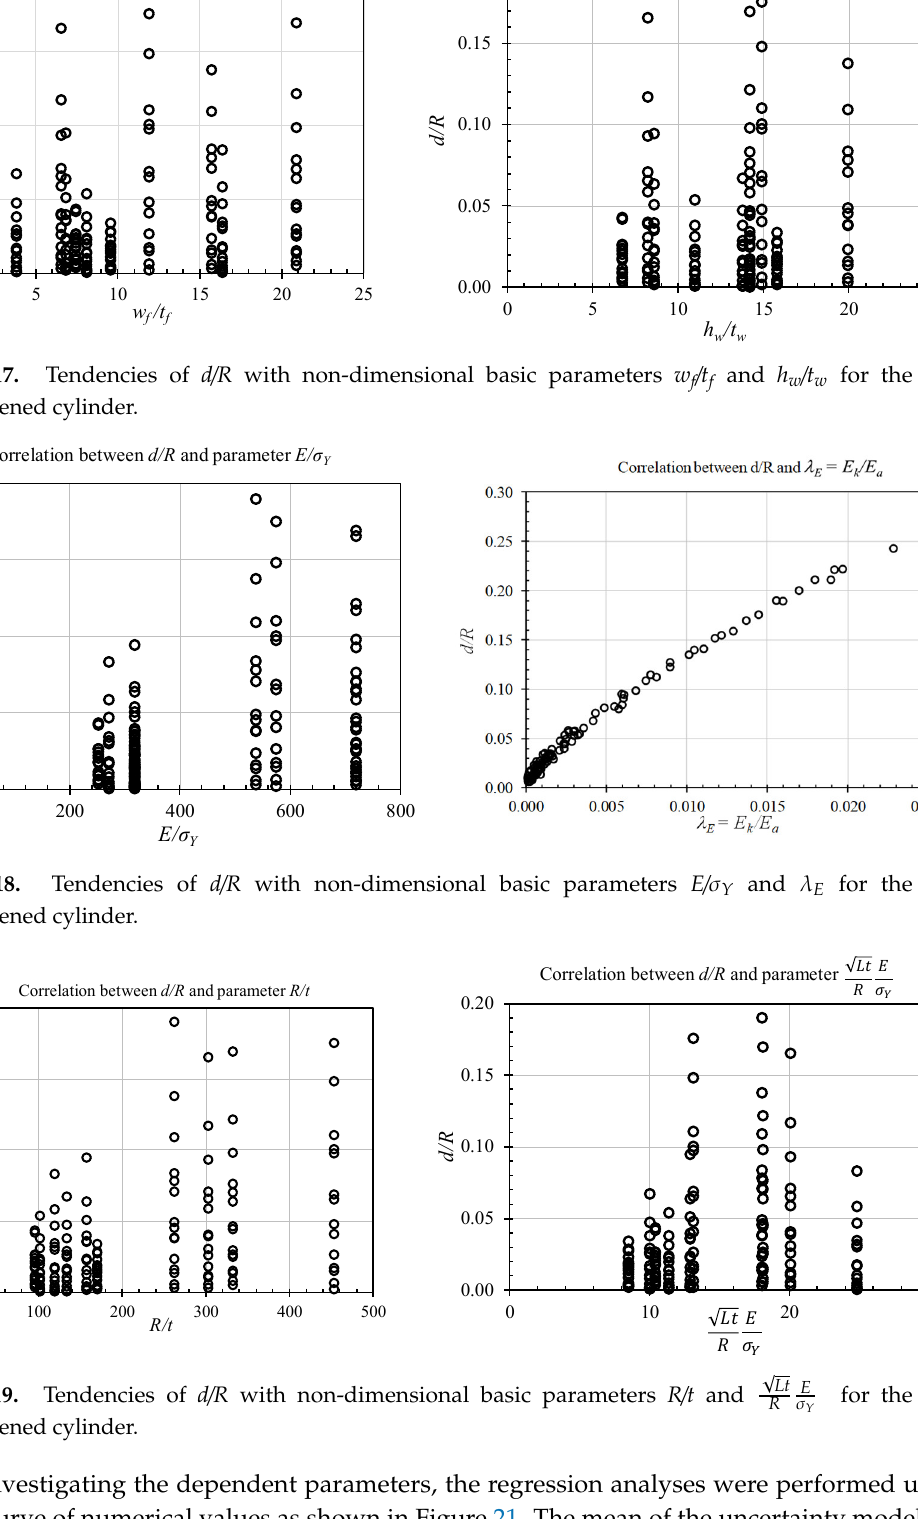
√  Lt for the  for the ring- for the ring-     for the ring-